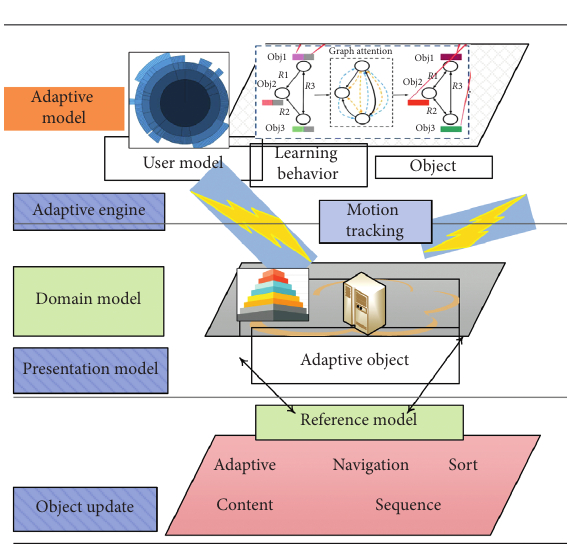
Figure 2: Adaptive object reference